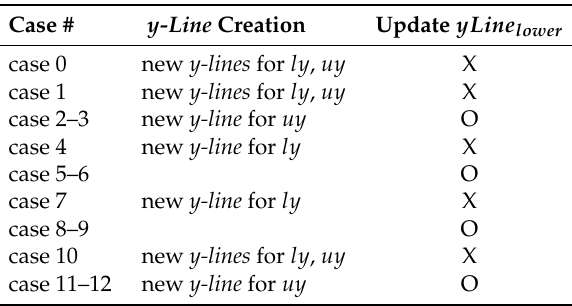
Figure 8. Cases of a pair of consecutive y-lines . Table 1. Update policy for each